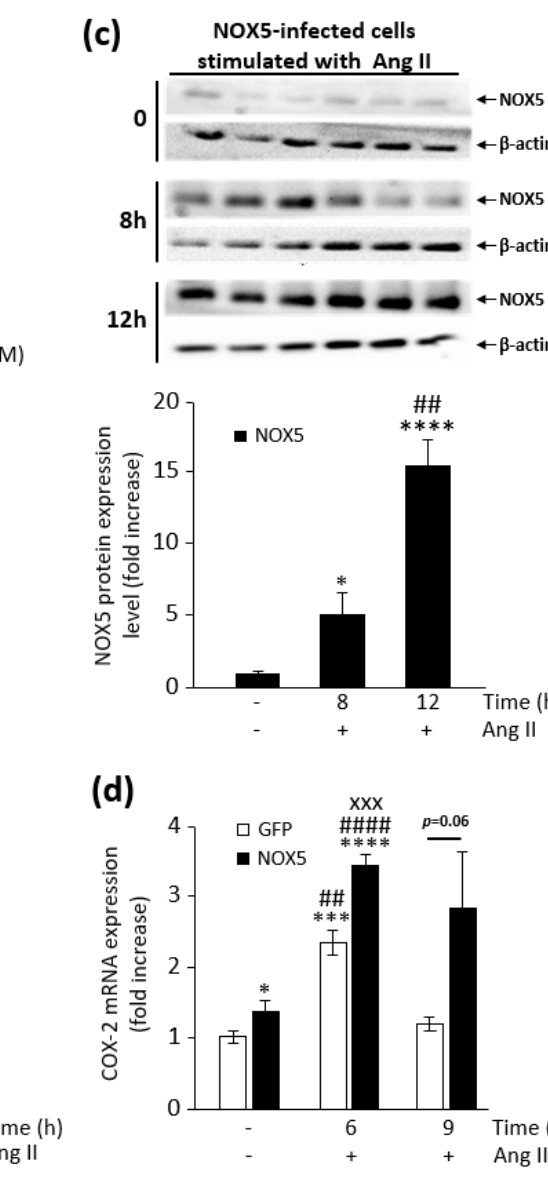
Figure 5. Characterization of the effect of NOX5 stimulation by angiotensin II (Ang II) in TeloHAEC. ( a ) ROS production measurements in NOX5- β - and GFP-infected cells for 24 h, and then stimulated with 0.1 µM Ang II. n = 6. * p < 0.05 vs. GFP, *** p < 0.001 vs. GFP, ### p < 0.001 vs. NOX5, and xx p < 0.01